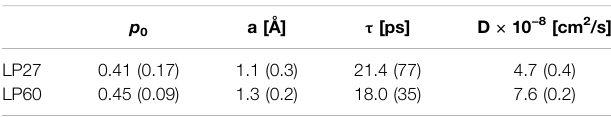
TABLE 1 | Summary of the dynamics parameters obtained by the global fi tting to the QENS spectra. The values in the parentheses are errors associated with the fi